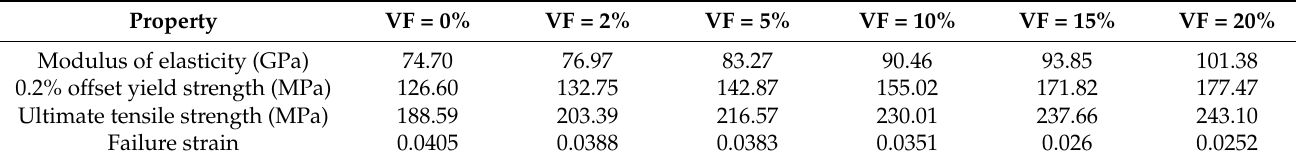
Figure 5. Effect of SiC particles volume fraction on the true stress–strain curve of A359/SiC compo- site (particle size (PS) = 10 µm). Table 2. Effect of SiC particle volume fraction on the mechanical properties of A359/SiC composites (PS = 10 µm).